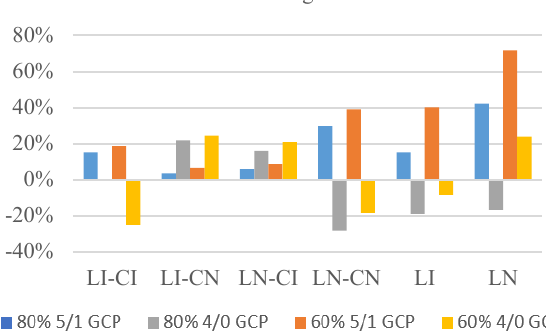
Figure 5 . GCP vs GNSS RMSZ gain for each of the six basic configurations and side-lap percentage. Positive values mean GNSS is more accurate, negative ones the contrary.